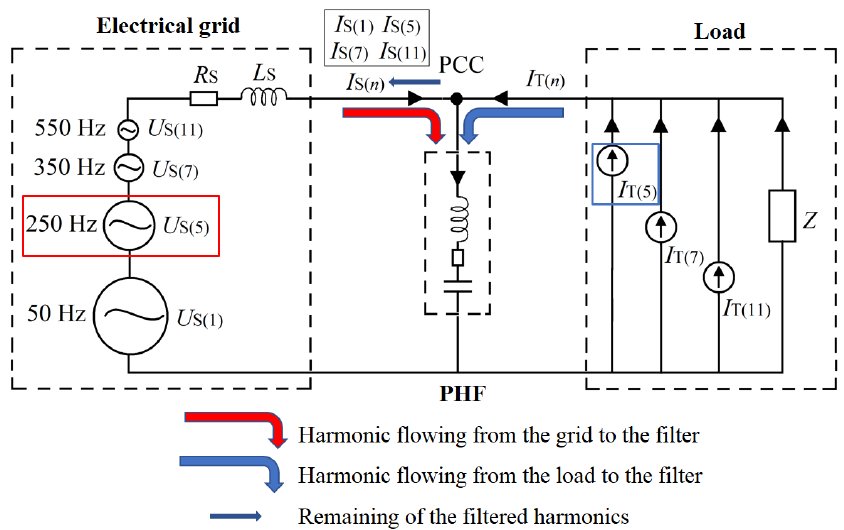
Figure 64. Equivalent circuit of the electrical system showing the flow of harmonics.